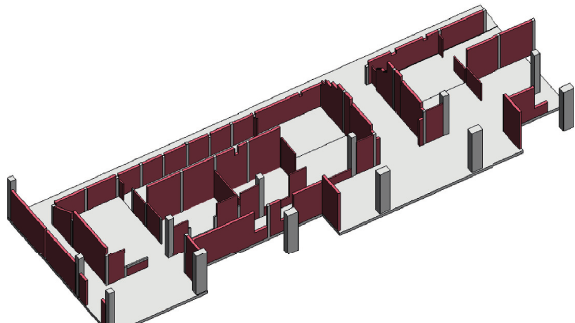
Figure 5: The BIM model created from the obtained point cloud by Revit software.